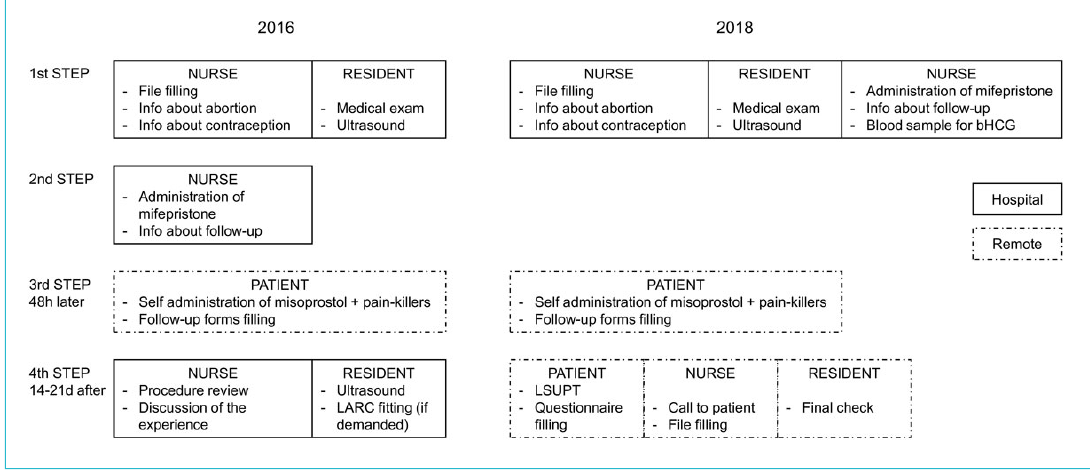
Figure 1: Comparison between IMAD2016 and IMAD2018. LSUPT = low-sensitivity urine pregnancy test (detection limit 1000 IU beta-human chorionic gonadotrophin